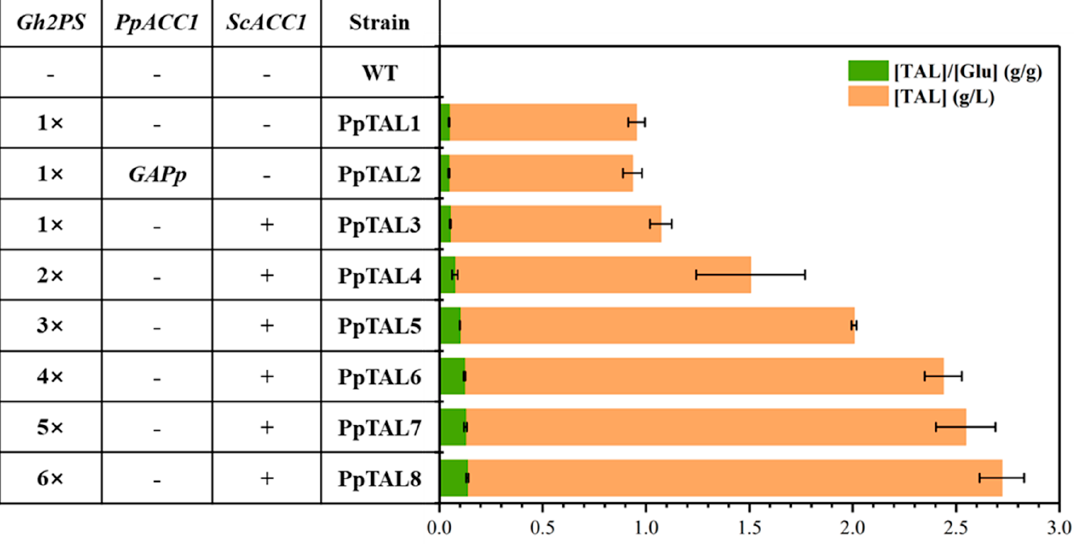
Figure 2. Improving TAL production in P. pastoris through metabolic engineering. TAL titer was improved by introducing the posttranslational regulation-free acetyl-CoA carboxylase mutant en- coding gene from S. cerevisiae ( ScACC1* ) and increasing the copy number of Gh2PS . All strains were fermented in YPD medium. The data represent three biological replicates, and the error bars represent standard deviations.